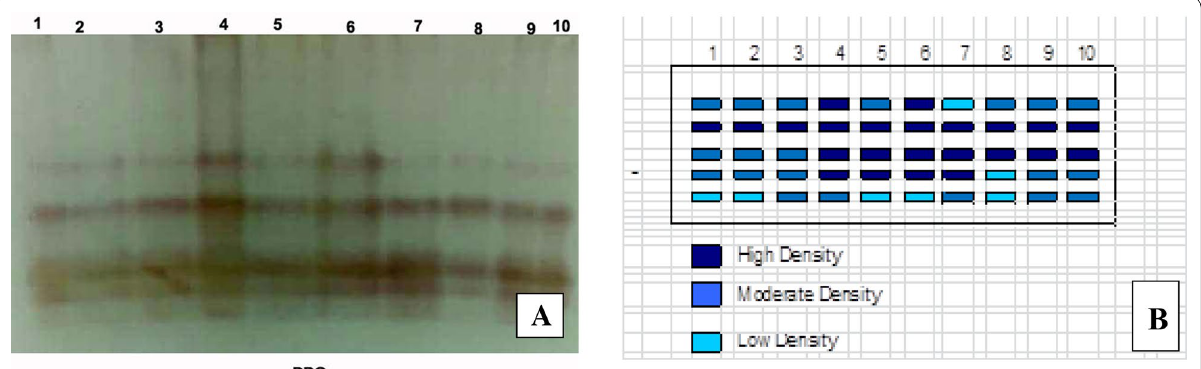
Fig. 7 Effect of F. oxysporum and endophytic isolates on PPO isozyme of tomato plants. A PPO, B Ideogram analysis of PPO isozyme (T1-Healthy control; T2-Infected control; T3-Healthy treated with A. flavus ; T4-Healthy treated with A. nidulance ; T5-Healthy treated with A. fumigatus ; T6-Healthy treated with combination of A. flavus, A. nidulance and A. fumigatus ; T7-Infected treated with A. flavus ; T8-Infected treated with A. nidulance ; T9-Infected treated with A. fumigatus and T10-Infected treated with combination of A. flavus, A. nidulance and A. fumigatus )